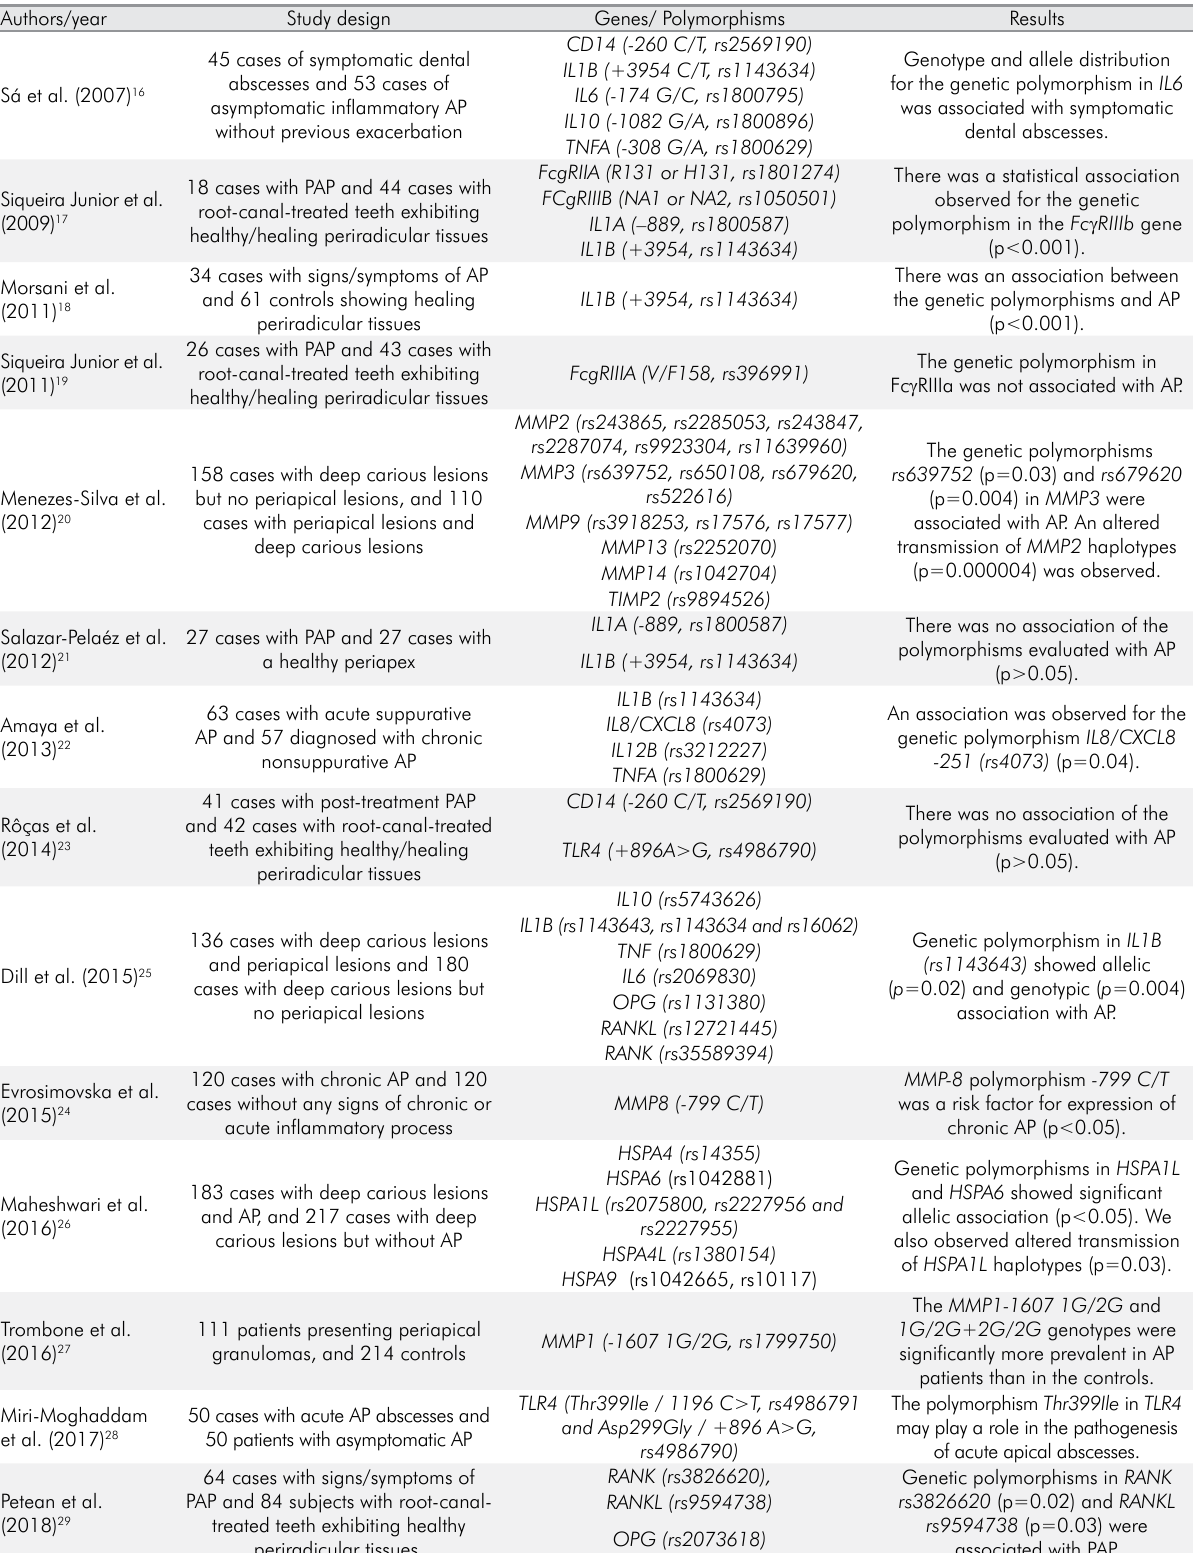
Table 3. List of articles and genetic polymorphisms evaluated by the